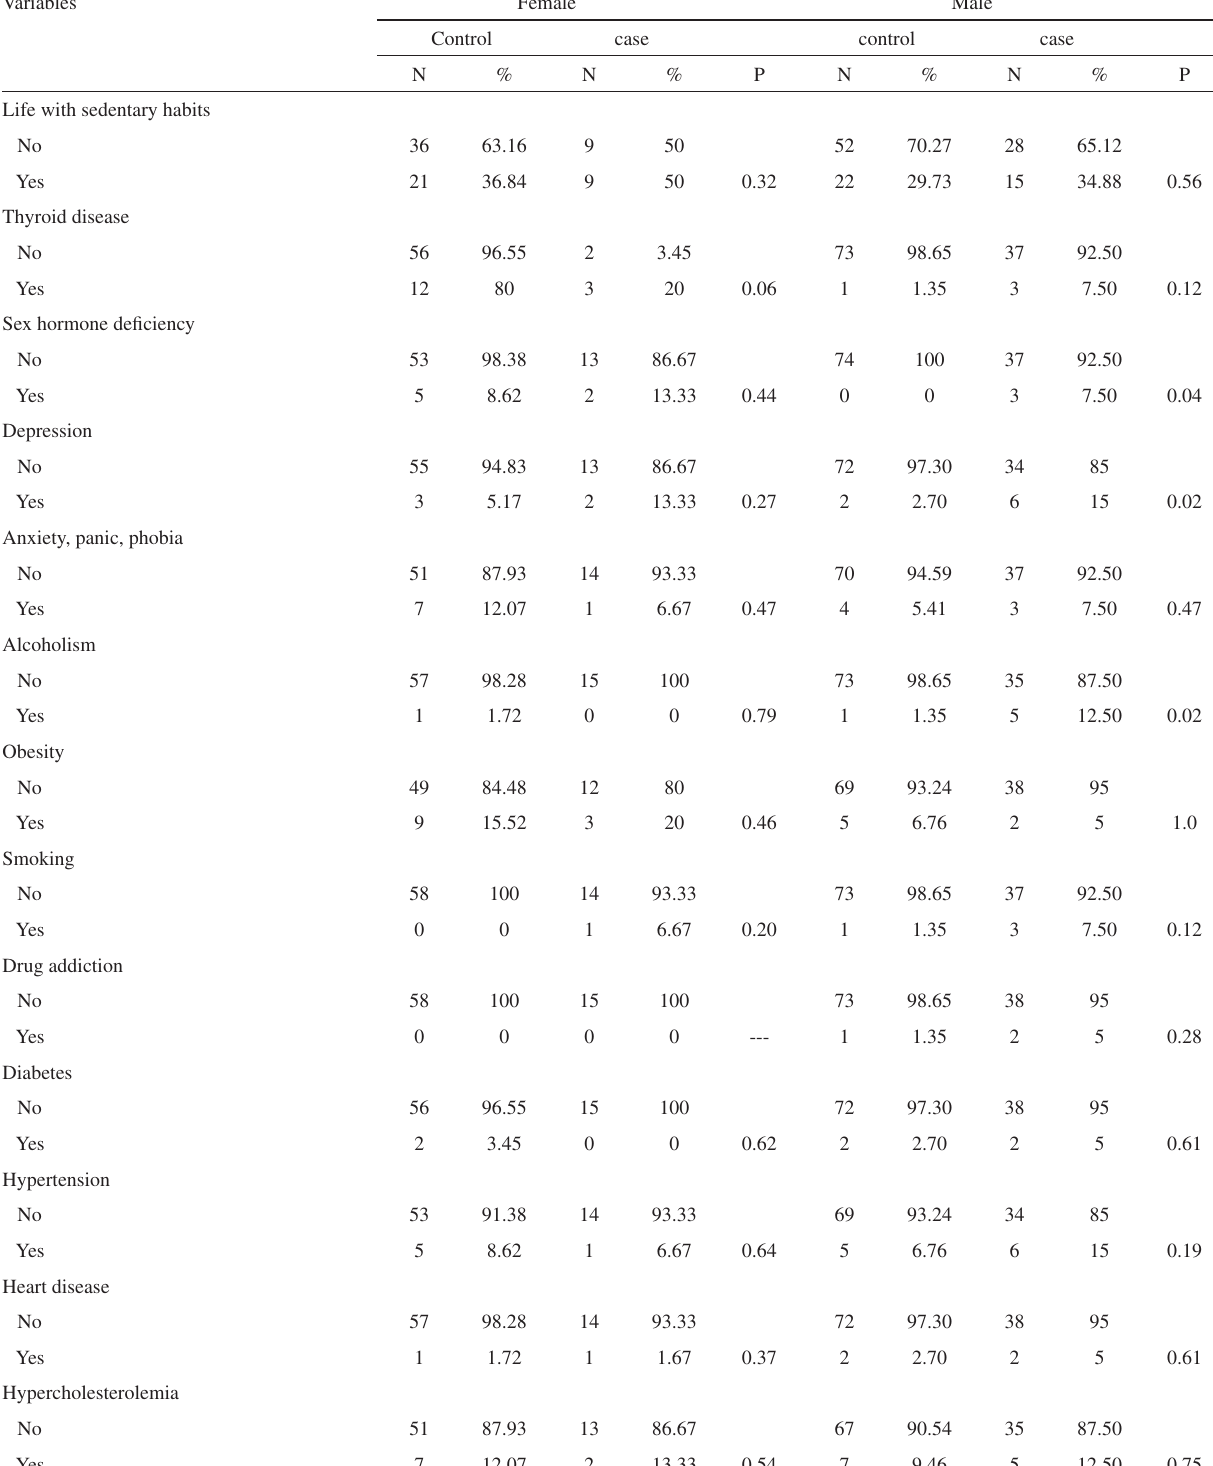
Table 3 - Frequency distribution of controls and cases according to risk factors for sexual dysfunction. Variables Female